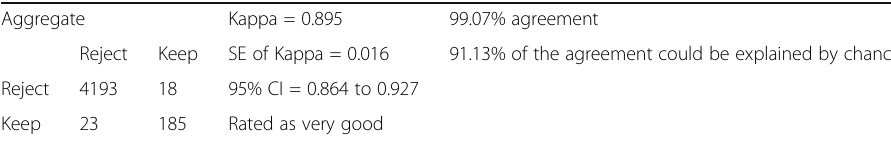
Table 1 Screening phase: review of titles and abstracts — relative agreement as indicated by Cohen ’ s Kappa